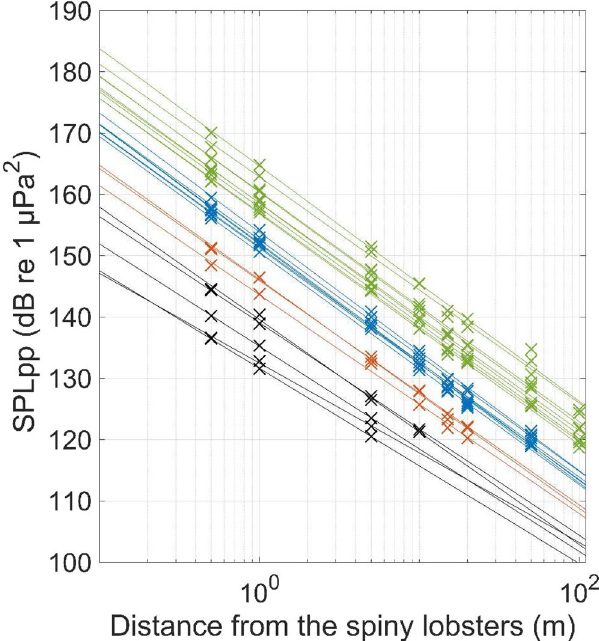
Figure 1. Evolution of sound pressure levels in peak-to-peak (SPL pp ; crosses) recorded at different distances from the spiny lobsters (between 0.5 and 100 m) and their calculated fit curves using logarithmic models (continuous lines). Each point represents the mean SPL pp averaged on 10 sounds. The x-axis is in logarithmic scale. Each value calculated at 1 m corresponds to the source level (SL pp ) of the spiny lobsters. The colors are related to the body size of the spiny lobsters (green: large, blue: intermediate, orange: small, black = very small).